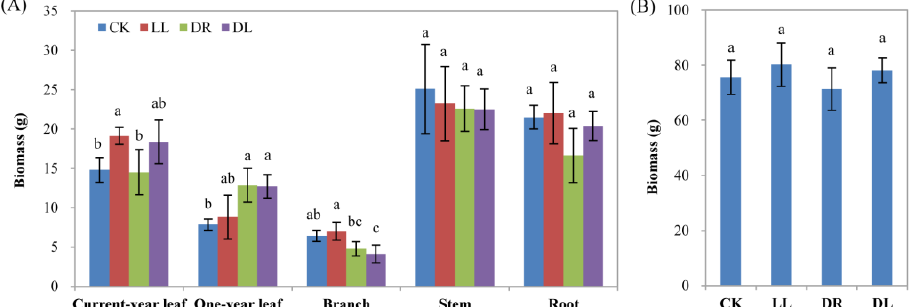
Figure 9. Effects of low light, drought, and their combined stress on dried biomass: ( A ) dried biomass in the different organs and ( B ) dried biomass in the whole plants. CK: control; LL: low light; DR: drought; and DL (DR + LL): the combined stress of drought and low light. Every treatment included three individual repeats; all the current-year leaves, one-year leaves, branches, stems, and roots were harvested for each repeat. Error bars represent means ± SE, and lowercase letters represent a significant difference of p < 0.05 in the same organs or the whole plants among the treatments.